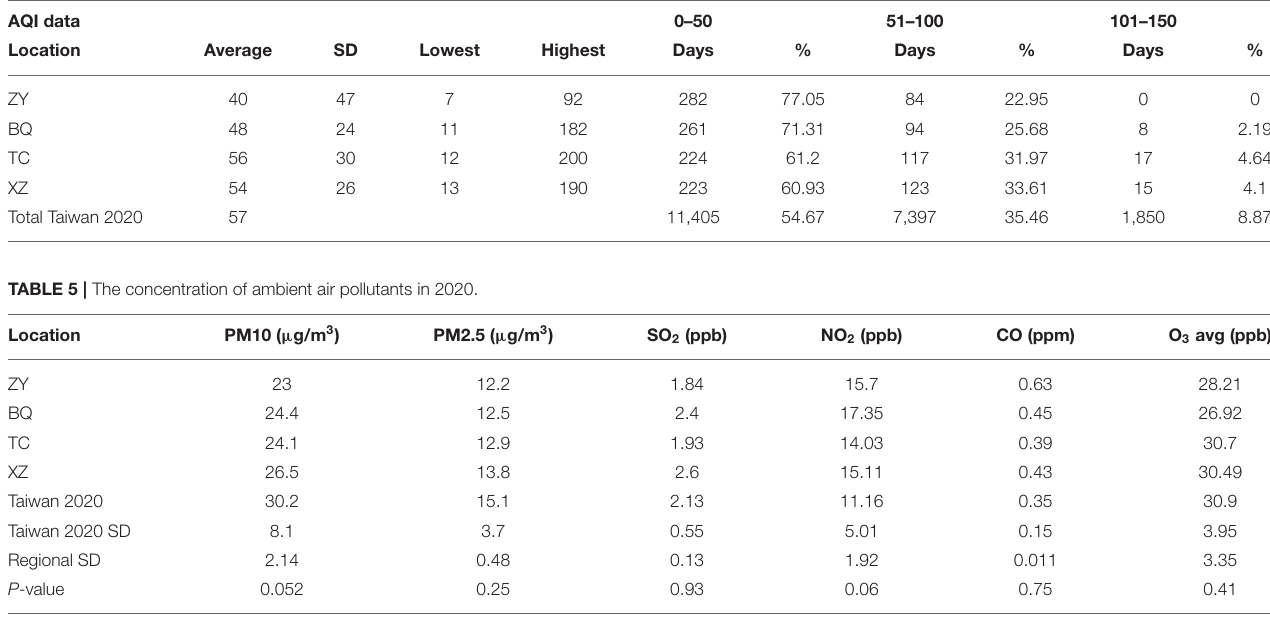
TABLE 4 | Air quality index.